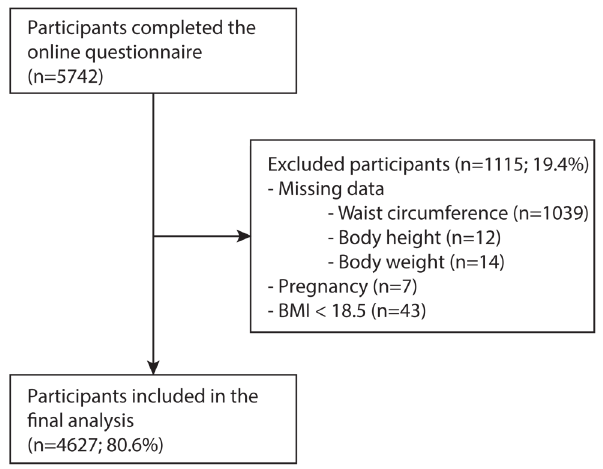
Figure 1. Flowchart enrolment of the study population. 5742 participants completed the online questionnaire. 1115 participants were excluded because of missing data (n=1065), pregnancy (n=7), or BMI , 18.5 (n=43). The final group sample consisted of 4627 participants.